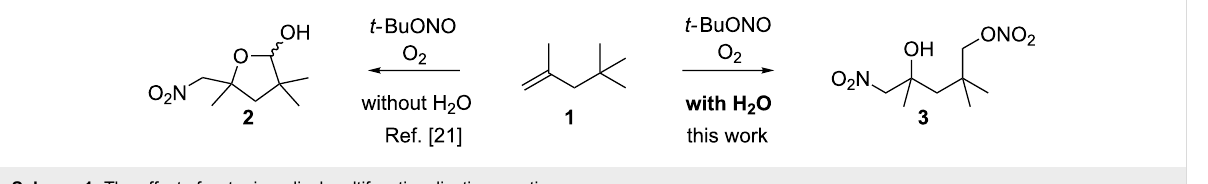
Scheme 1: The effect of water in radical multifunctionalization reactions.